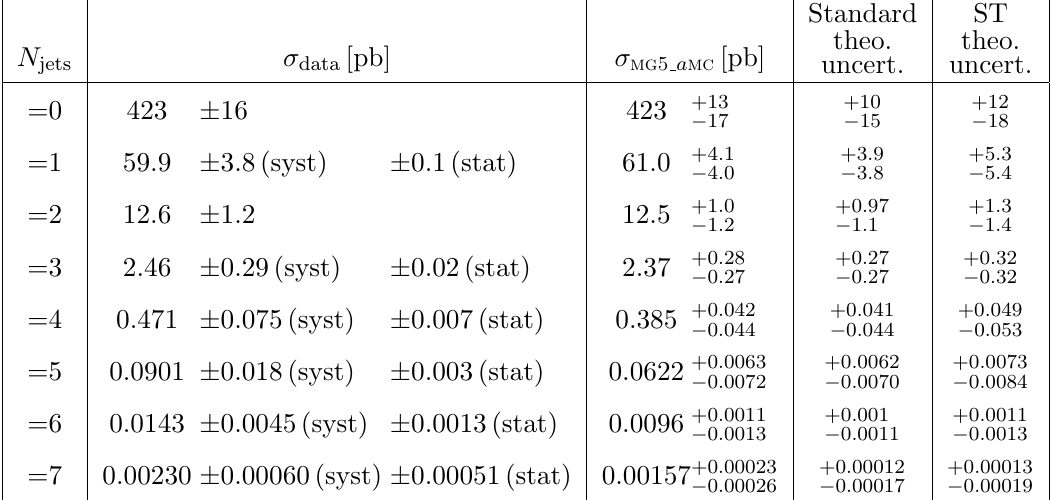
Table 3 . Measured ( (cid:27) data ) and calculated cross sections of the production of Z + N jets jets events. The cross section calculated with mg5 a mc is given in the third column together with the total uncertainty that covers the theoretical (standard method), PDF, (cid:11) s , and statistical uncertainties. The theoretical uncertainty obtained with the standard and ST methods are compared in the two last columns. The uncertainty on the measurement is separated in systematic and statistical components when the latter is not